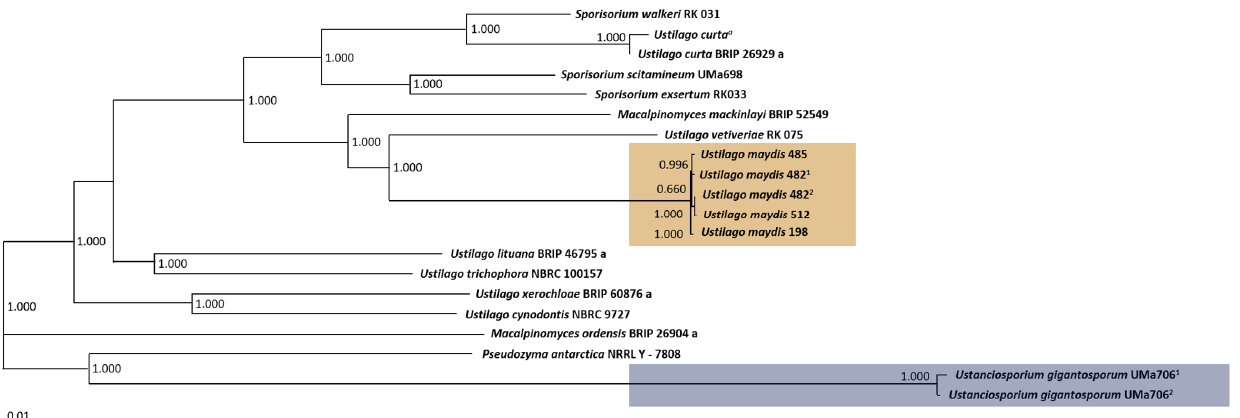
Figure 1. Phylogenetic tree of the investigated Ustilaginaceae strains. The phylogenetic tree is based on the core genes (2370 genes) of the selected strains. The SH-like local support values were computed using FASTtree within the comparative genomics tool EDGAR 3.0 [49]. 1,2 Two isolates were sequenced. a Additional strain isolated from sample #2836* (Table 1).